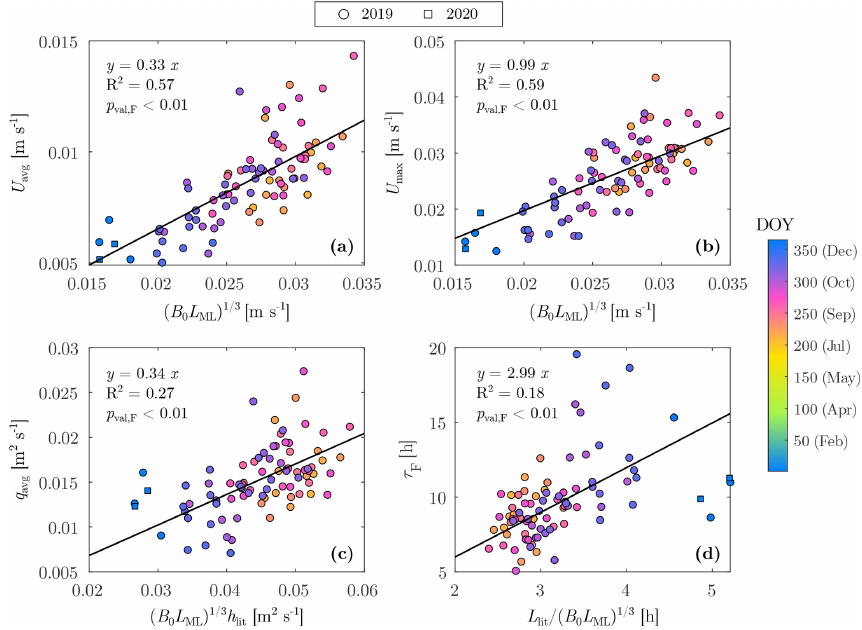
Figure 6. (a) Daily averaged cross-shore velocity, (b) daily maximum cross-shore velocity, (c) daily averaged unit-width discharge, and (d) flushing timescale as a function of scaling formulae (Sect. 2.6). The equation of the linear regressions with 0 intercept, the coefficient of determination ( R 2 ), and the p value of an F test ( p val , F ) are